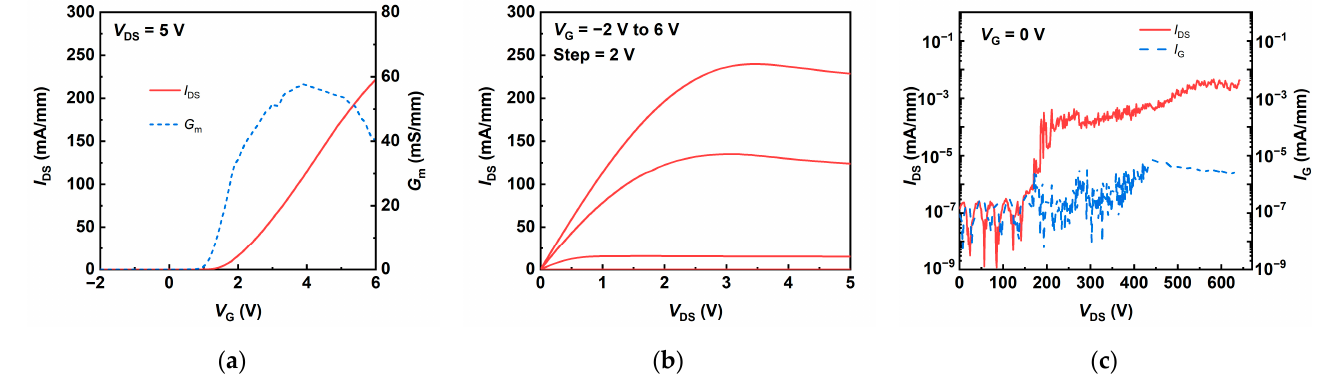
Figure 5. ( a ) Transfer characteristic; ( b ) output characteristic; ( c ) breakdown curve of the p-GaN HEMT obtained via H ion implantation with energy of 15 keV and a dose of 1.5 × 10 13 cm − 2 , after annealing at 400 °C .